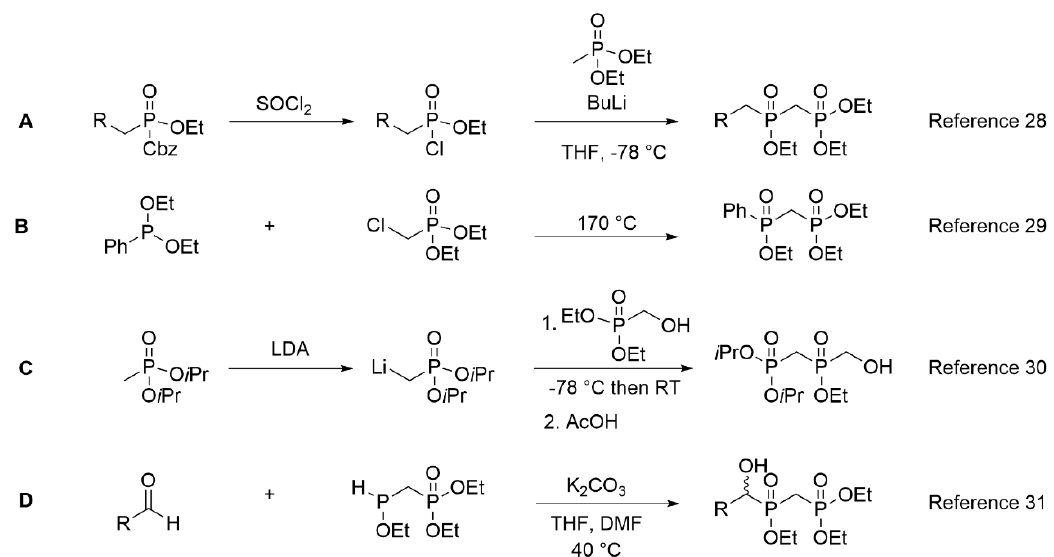
Figure 4. Phosphinophosphinate synthesis strategies already described on non-glycosidic molecules.